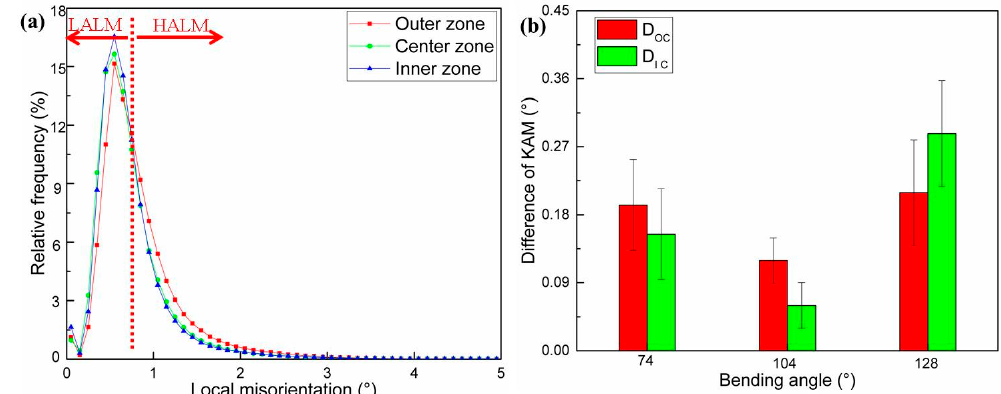
Figure 7. Change in local misorientation and difference in kernel average misorientation (KAM). ( a ) Change in local misorientation of bending specimen at 104° angle; ( b ) Difference in kernel average misorientation with specimens strained at different bending angles. LALM: low-angle local misorientation; HALM: high-angle local misorientation.